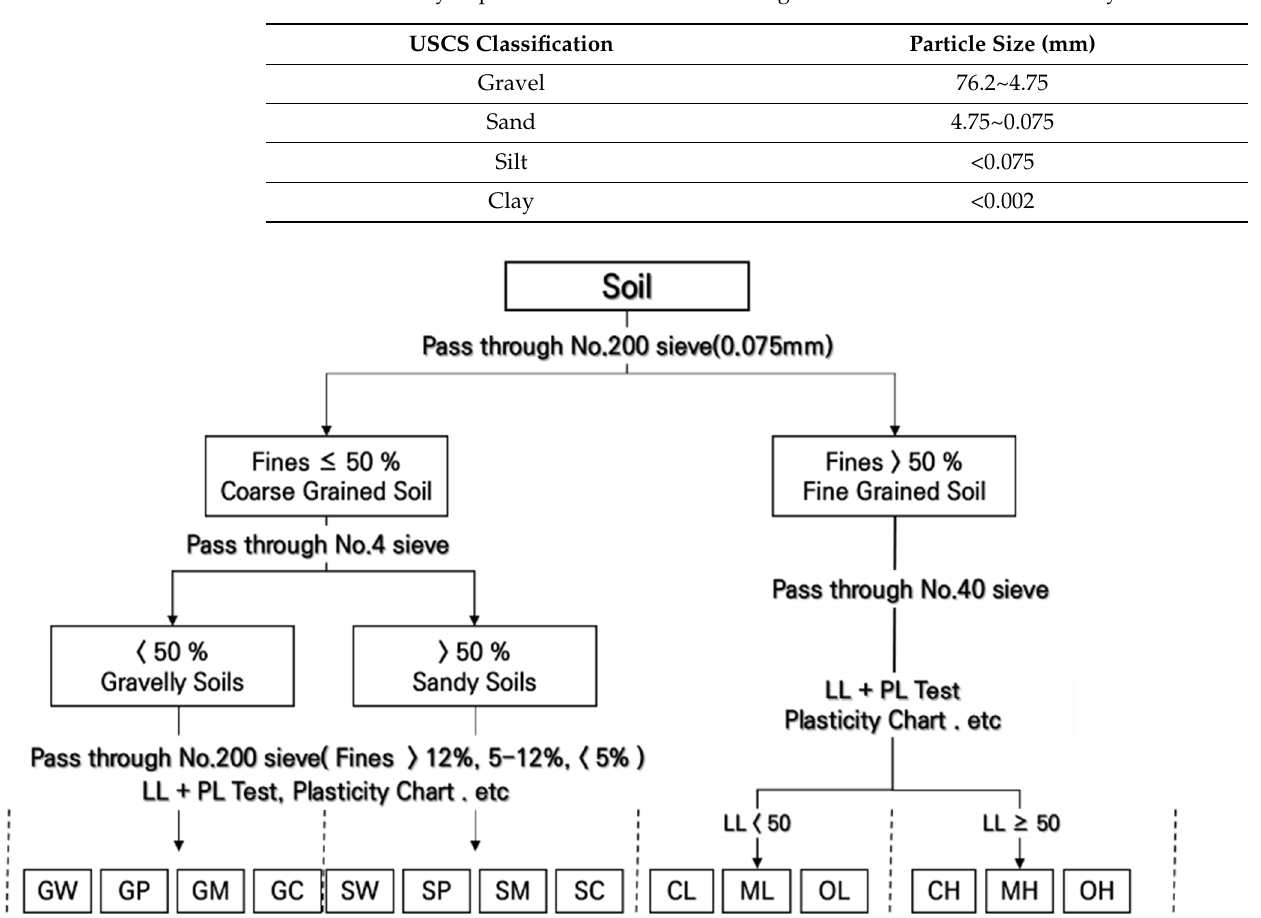
Figure 1. Soil classification of the Unified Soil Classification System.